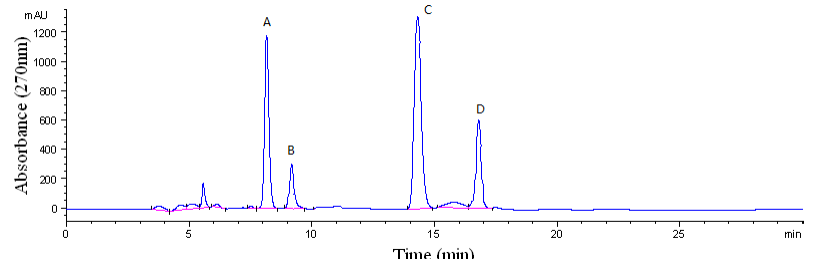
Figure 2. High-performance liquid chromatography (HPLC) chromatogram of the crude extract from the leaves of N . nucifera . Sample: Column: Discovery C18